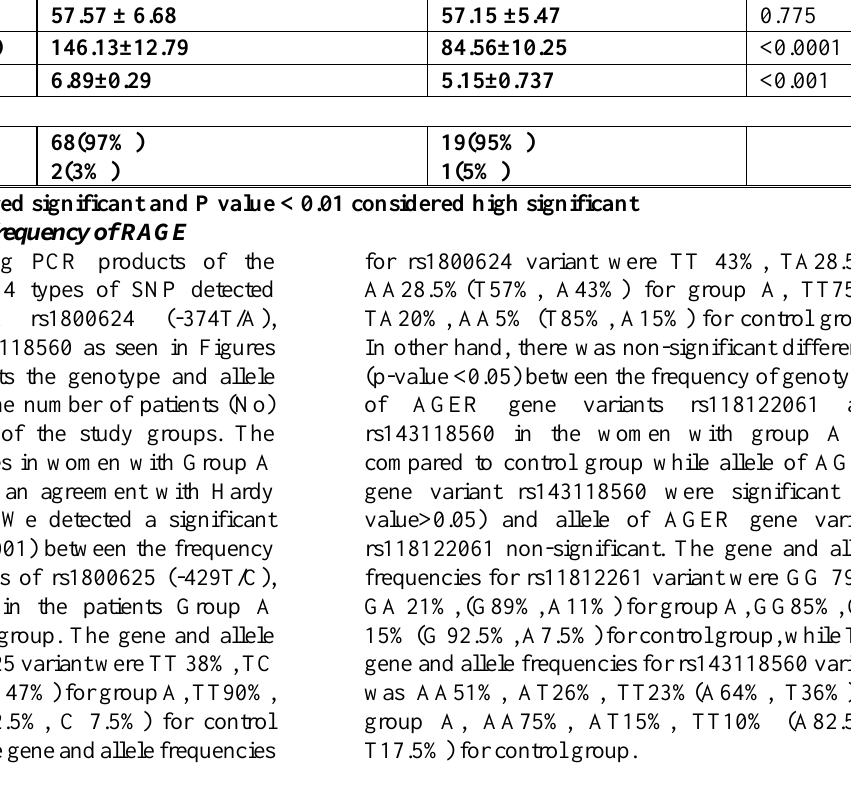
Table 2. Comparison between characteristic and biochemical parameters of the study groups